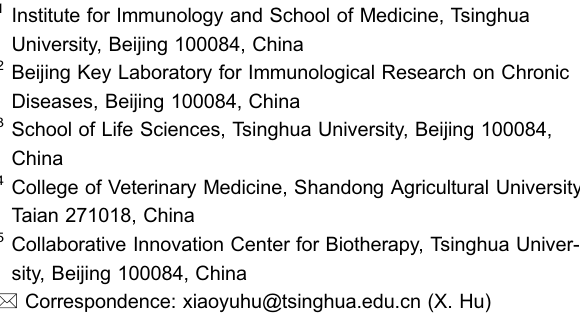
Figure 2. TLE4 suppresses production of IL-6 and IL-12 and protects host from septic shock . (A)Quantitativereal-time PCR analysis of Tle4 mRNA inBMDMs obtainedfrom littermates of Tle4 +/+ , Tle4 +/ − and Tle4 − / − mice. ND, not detected. (B) Quantitative real-timePCRanalysisof Il6 and Il12b mRNAin Tle4 +/+ , Tle4 +/ − and Tle4 − / − BMDMs with or without LPS stimulation. (C) Cumulative results of Il6 and Il12b mRNA in Tle4 +/+ and Tle4 − / − BMDMs stimulated with LPS for 3 h, presented relative to that in Tle4 +/+ BMDMs.(D)ELISAofIL-6andIL-12p40insupernatantsfrom Tle4 +/+ and Tle4 − / − BMDMs stimulated for the indicated periods with LPS. (E)Quantitativereal-timePCRof Tle4 mRNAinBMDMs from Lyz2 - Cre and Tle4 fl / fl Lyz2 -Cre (TLE4 cKO) mice. (F) Quantitative real- timePCRof Il6 and Il12b mRNAin Lyz2 -CreandTLE4cKOBMDMs with or without LPS stimulation. (G) Cumulative results of Il6 and Il12b mRNA in Lyz2 -Cre and TLE4 cKO BMDMs stimulated with LPSfor3h,presentedrelativetothatin Lyz2 -CreBMDMs.(H)ELISA of IL-6 and IL-12p40 in supernatants of BMDMs from Lyz2 -Cre and TLE4cKOmicestimulatedfortheindicatedperiodswithLPS.(Iand J) Survival rate (I) and body weight (J) of Lyz2 -Cre and TLE4 cKO mice injected intraperitoneally with 15 mg/kg of LPS. Data are representative of four (A, B and D) or six (E, F and H) independent are pooled from four (C), six (G), two (I), or three (J) independent (C and G) or unpaired (J) t